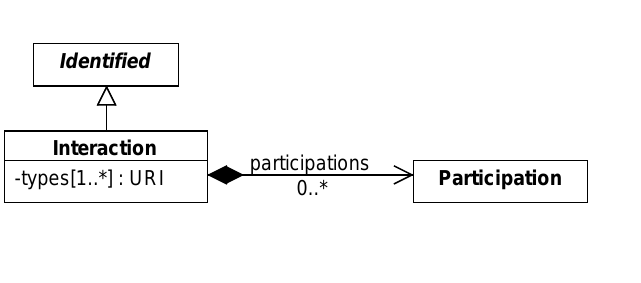
Figure 17: Diagram of the Interaction class and its associated properties.